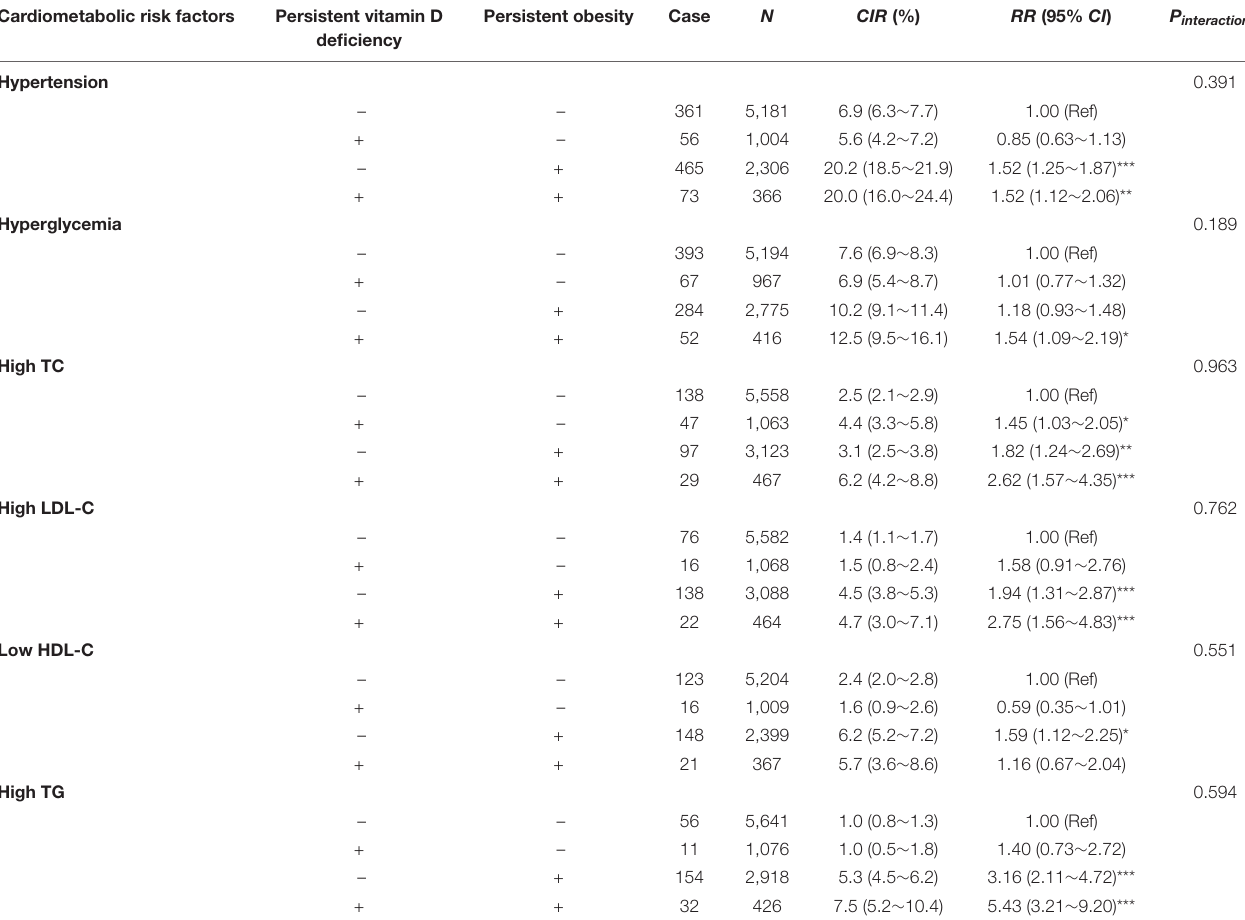
TABLE 3 | The joint effect [ RR (95% CI )] a of persistent vitamin D deficiency and persistent obesity on the cardiometabolic risk factors incident. Cardiometabolic risk